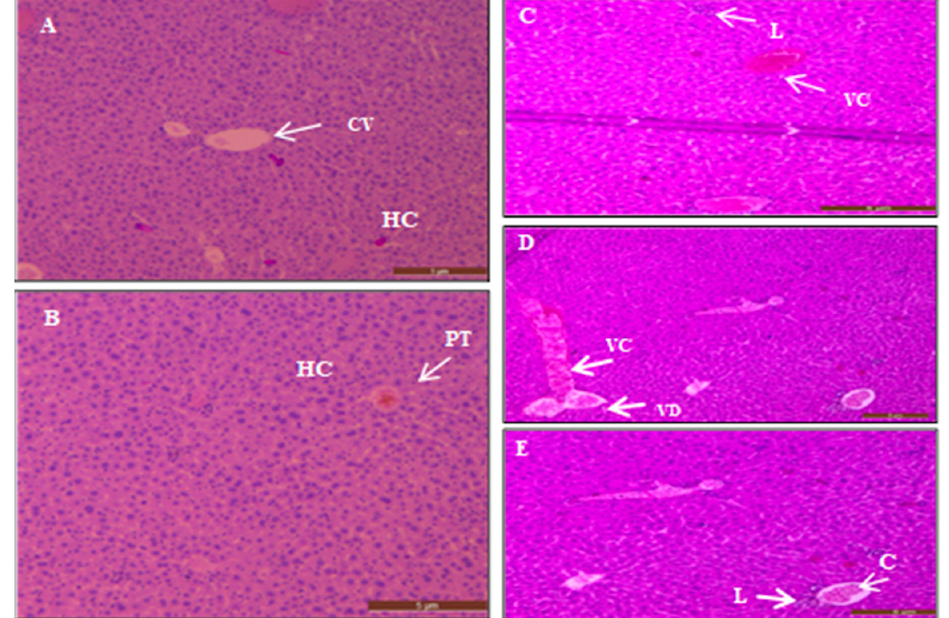
Figure 11. Transverse sections in the liver of control untreated mice. Showing the central vein (CV), plates of hepatic cells (HC), and sinusoids (S) in ( A ) portal tract (PT) in ( B ) stained with H and E stain. ( C ) Shows vascular congestion (VC) and few scattered inflammatory cells (lymphocytes) (L) in a liver section of treated mice with 200 mg/kg AgNPs. ( D ) Illustrates liver section of treated mice with 300 mg/kg AgNPs which shows vascular congestion (VC) characterized by dilated blood vessels filled with RBCs. A few hydropic changes and vacuolar degeneration (VD) occurred as a reversible injury. ( E ) Portal tract dilated vein filled with RBCs (congestion) (C) and a few scattered inflammatory cells (Lymphocytes) (L). Stained with hematoxylin and eosin. Scale bar = 5 μ m.